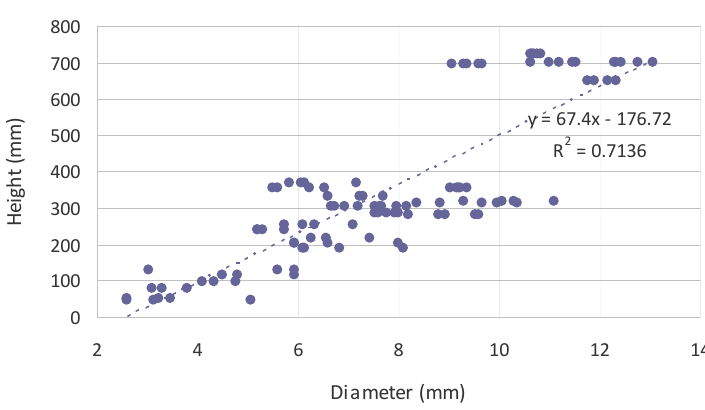
Figure 19. Correlation analysis between the diameter of the cotton plant’s height to the bark thickness.